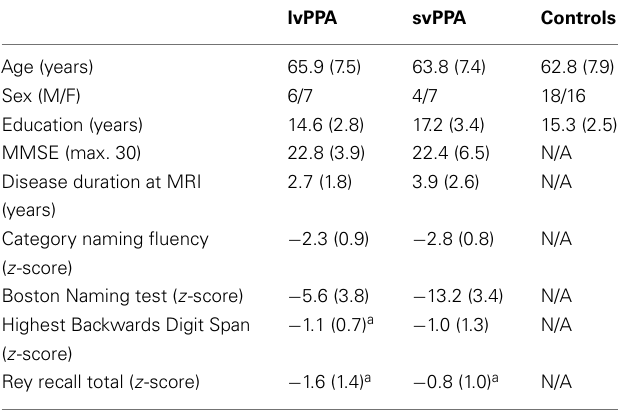
Table 1 | Mean ( ± SD) clinical and demographic features and neuropsychological